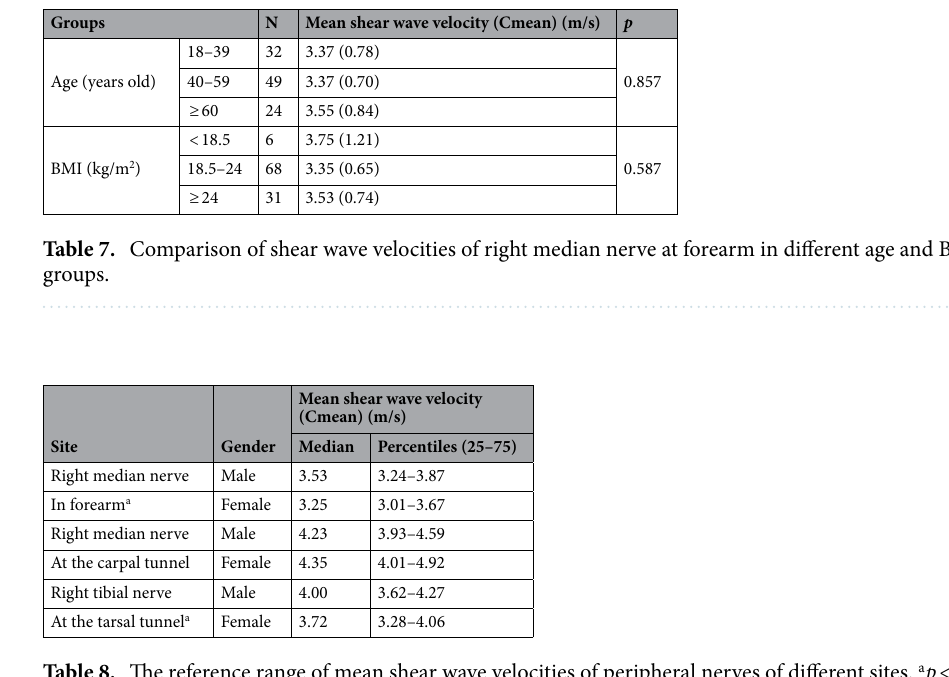
Table 8. The reference range of mean shear wave velocities of peripheral nerves of different sites. a p < 0.01.